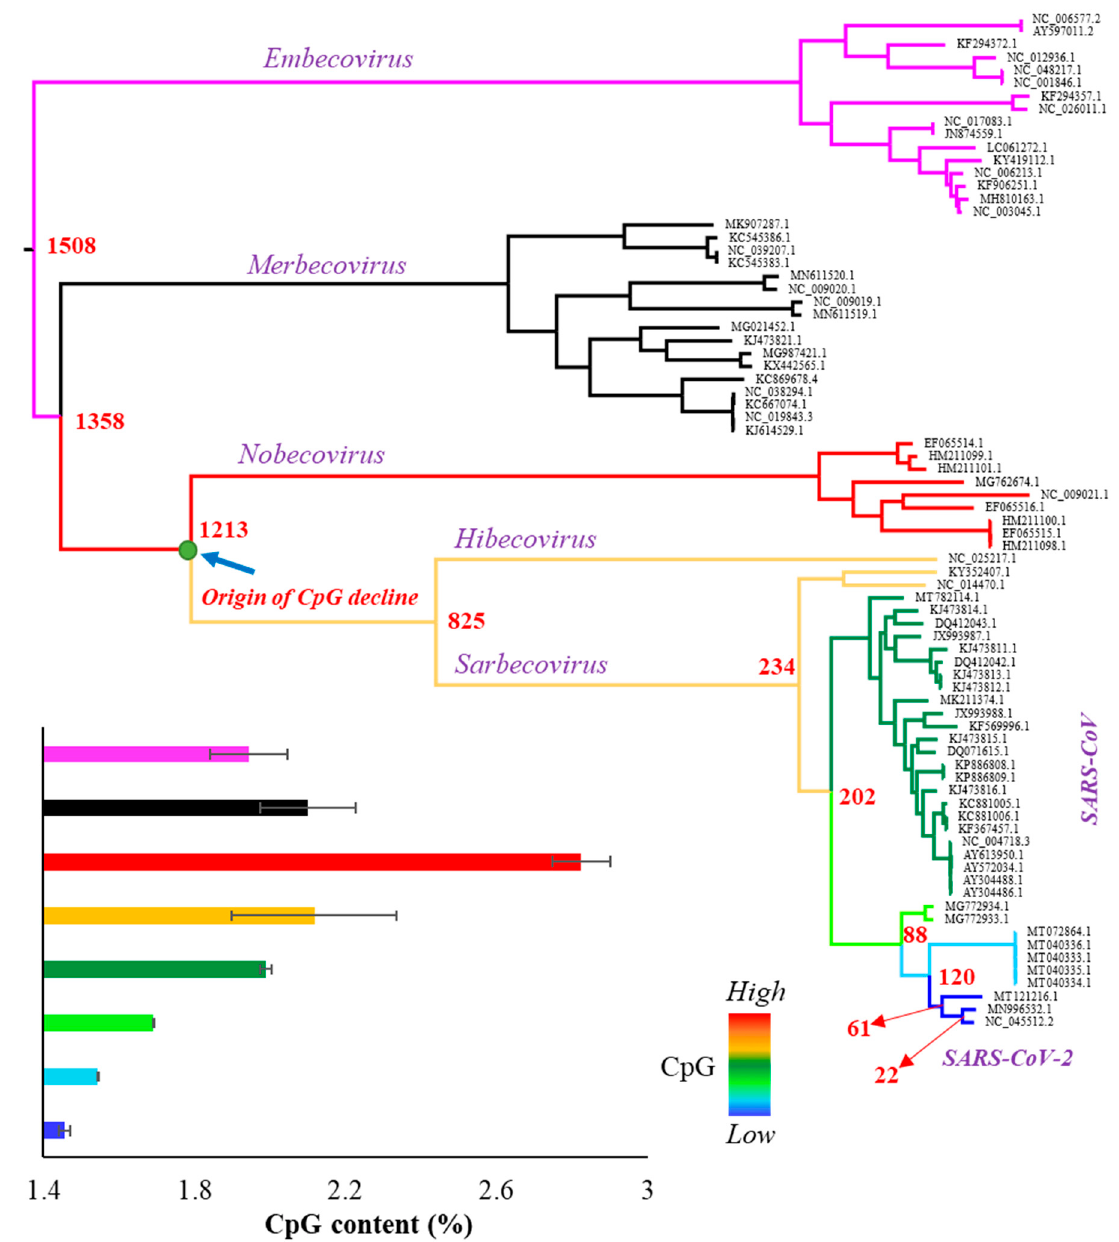
Figure 1. Phylogenetic relationship among 79 representative genomes (Supplementary Table S1) belonging to the genus Betacoronavirus including severe acute respiratory syndrome coronavirus 2 (SARS-CoV-2) (NC_045512.2). The tree was inferred using the maximum likelihood method. Red to blue colors indicate the levels of CpG content: red (2.82%), orange (2.12%), dark green (1.98%), pale green (1.69%), sky blue (1.54%), and dark blue (1.46%). Bayesian MCMC method base was used to estimate the time of divergence for each node that are shown in red (Supplementary Figure S1). Inset: column graph showing the CpG contents (%) of various clades of the tree. Error bars indicate standard error of the